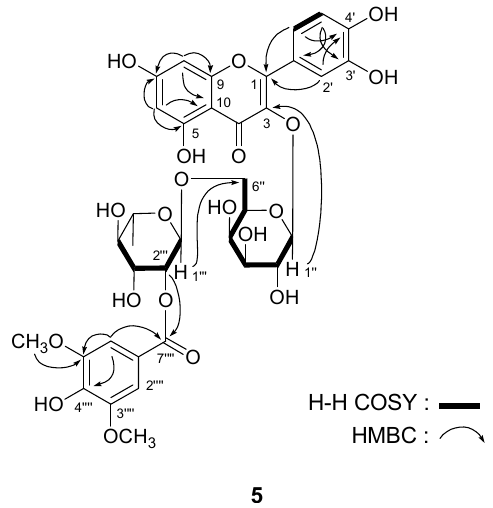
Figure 4. The main 1 H- 1 H COSY and HMBC correlations of compound 5 .